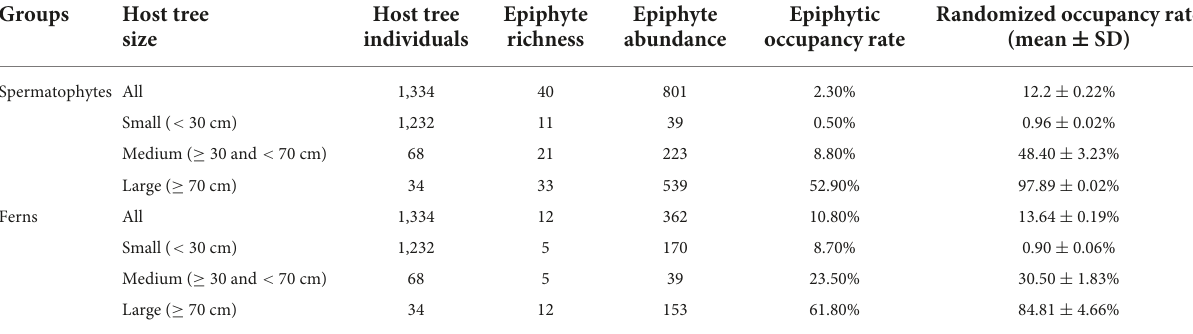
TABLE 2 Spatial patterns of epiphytic spermatophytes and ferns in a 1.1 ha tropical rainforest (Yunnan, SW China).